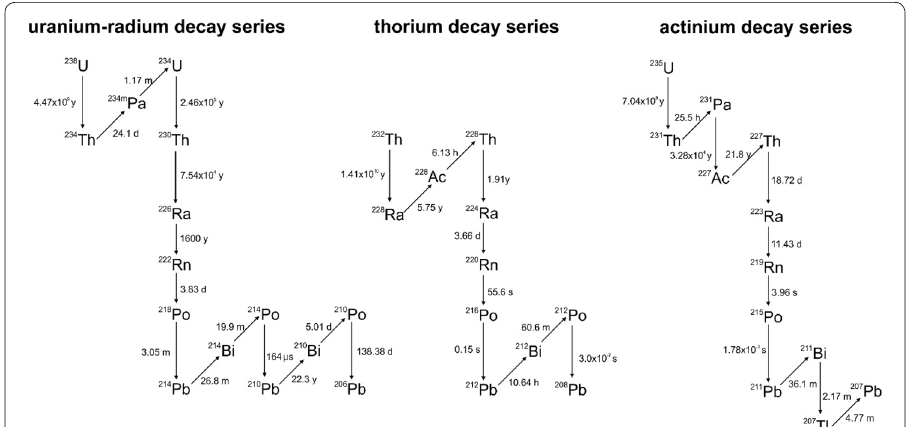
Fig. 1 Uranium–radium, thorium and actinium decay series. Vertical arrows indicate alpha decay, diagonal arrows indicate beta decay. For radionuclides with more than one decay mode, only the most frequently occurring is